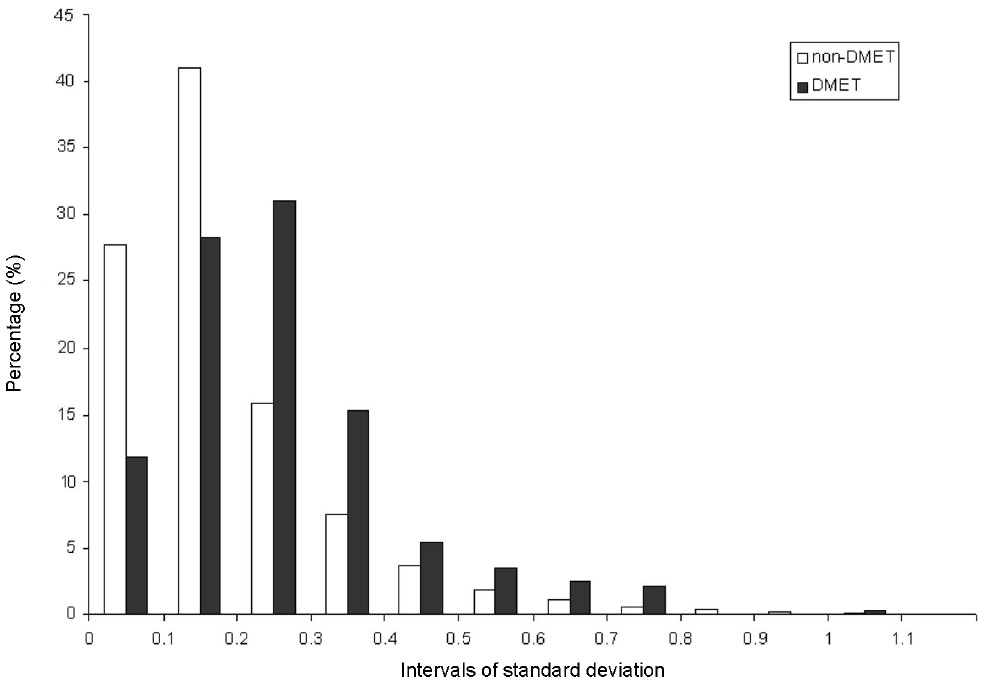
Figure 1. The standard deviation (SD) for the expression of DMET and non-DMET genes among 427 individuals. The DMET genes appear to have a higher likelihood of having high SD compared to non-DMET genes. The X-axis shows the SD interval and Y-axis represents the probability of 427 individuals with an indicated SD interval value.